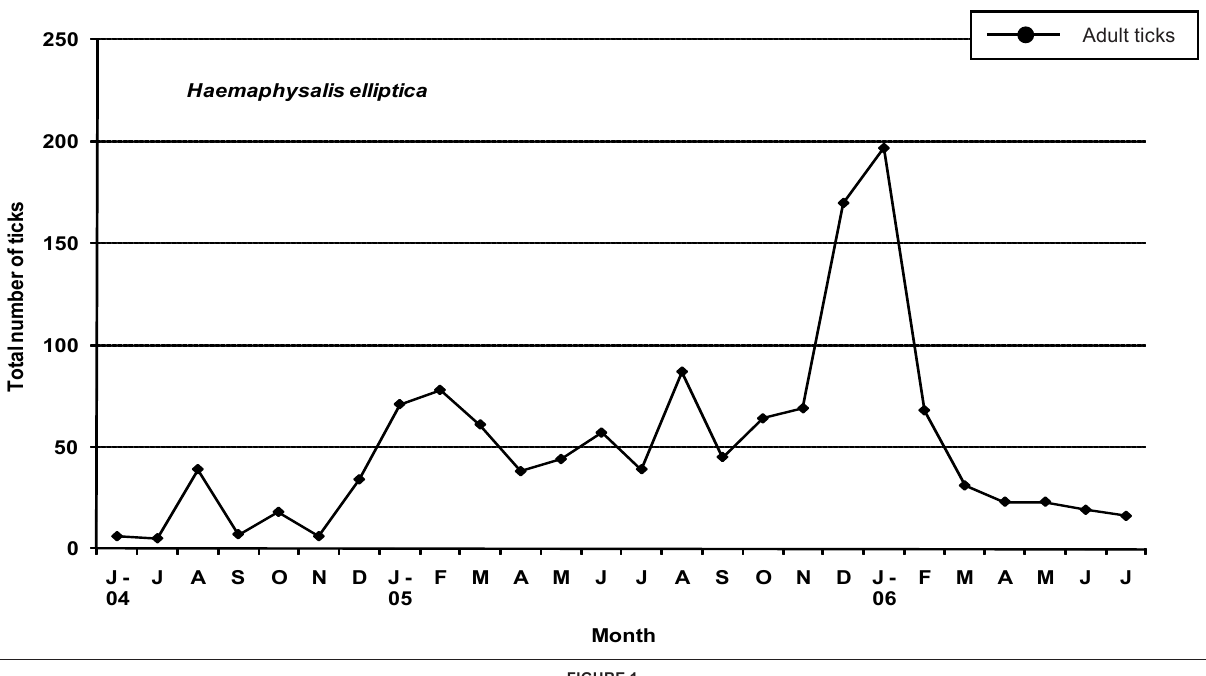
FIGURE 1 Total numbers of adult Haemaphysalis elliptica collected each month, from June 2004 to July 2006, from a male domestic cat in the eastern suburbs of Pretoria, Gauteng Province, South